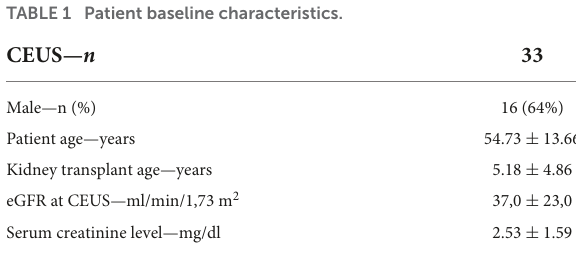
TABLE 1 Patient baseline